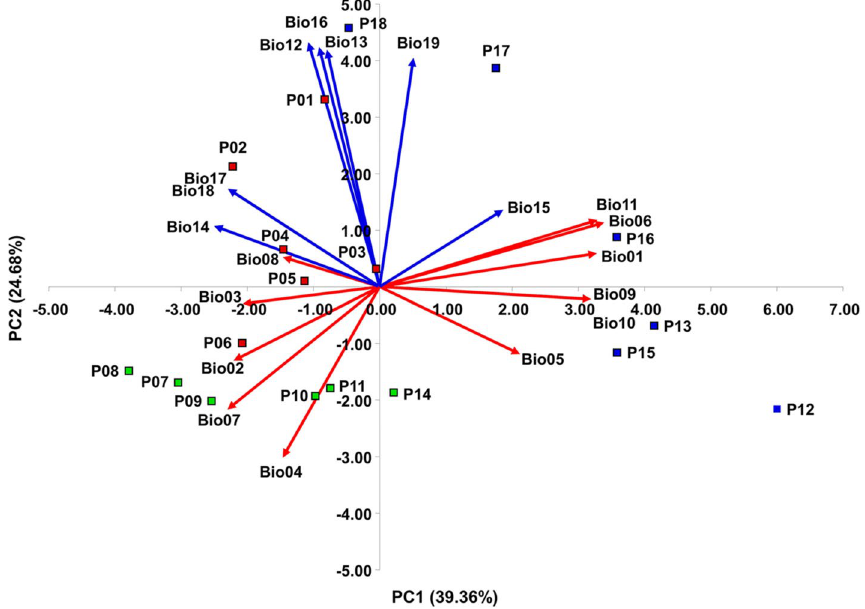
Figure 2. Biplot obtained by Principal Component Analysis (PCA) based on 19 bioclimatic variables for 18 H. italicum sampling sites. Red vectors represent temperature-related variables and blue vectors precipitation- related variables. Northern Adriatic H. italicum populations (P01–P06) are colored in red, central populations in green (P07–P10) and southern populations (P11–P18) in blue